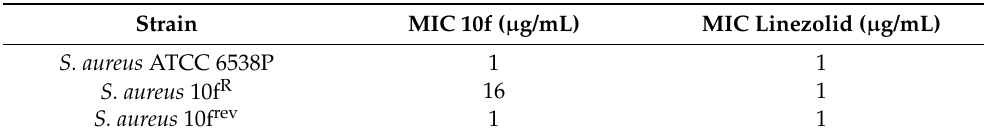
Table 3. 10f and linezolid MIC values calculated against S. aureus wild type (ATCC6538P), 10f resistant (10f R ) and 10f revertant (10f rev ) strains.